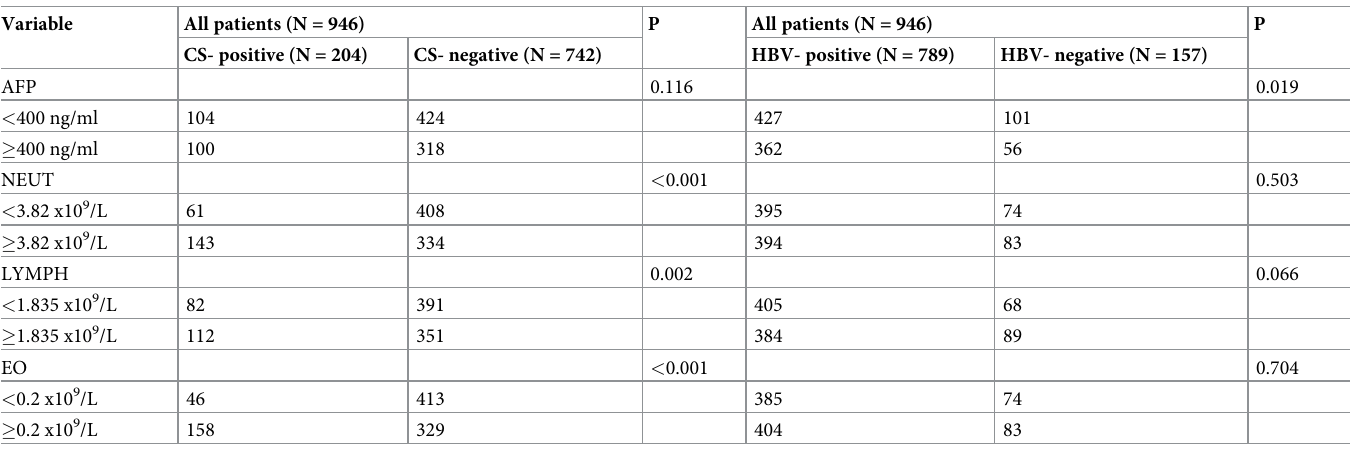
BCLC: Barcelona Clinic Liver Cancer Staging System. MVI: Microvascular invasion. HBsAg: hepatitis B surface antigen. TBil: total bilirubin. AST: aspartate aminotransferase. ALT: alanine aminotransferase. NEUT: absolute neutrophil count. EO: the absolute number of eosinophils. LYMPH: absolute lymphocyte count.